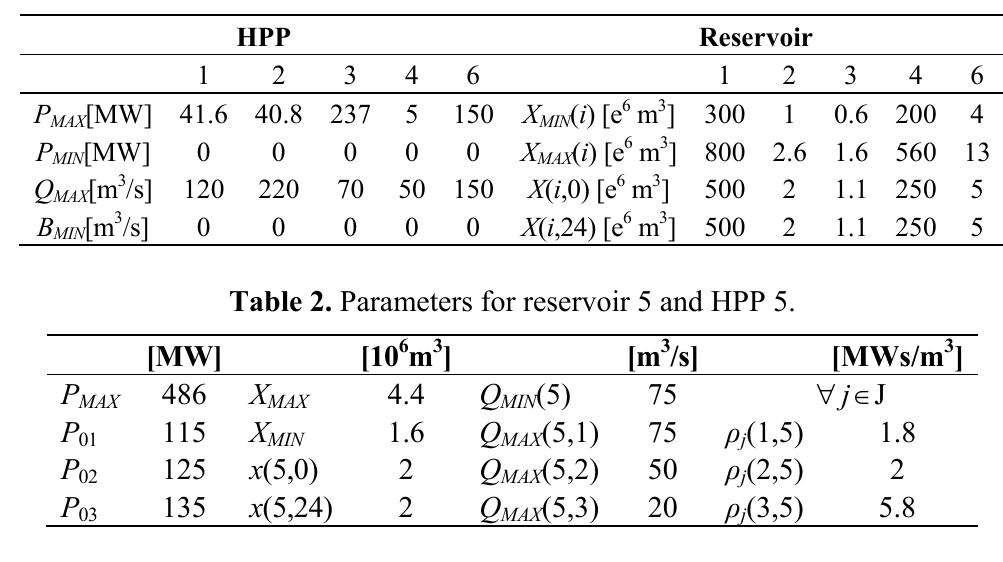
Table 1. Input parameters.